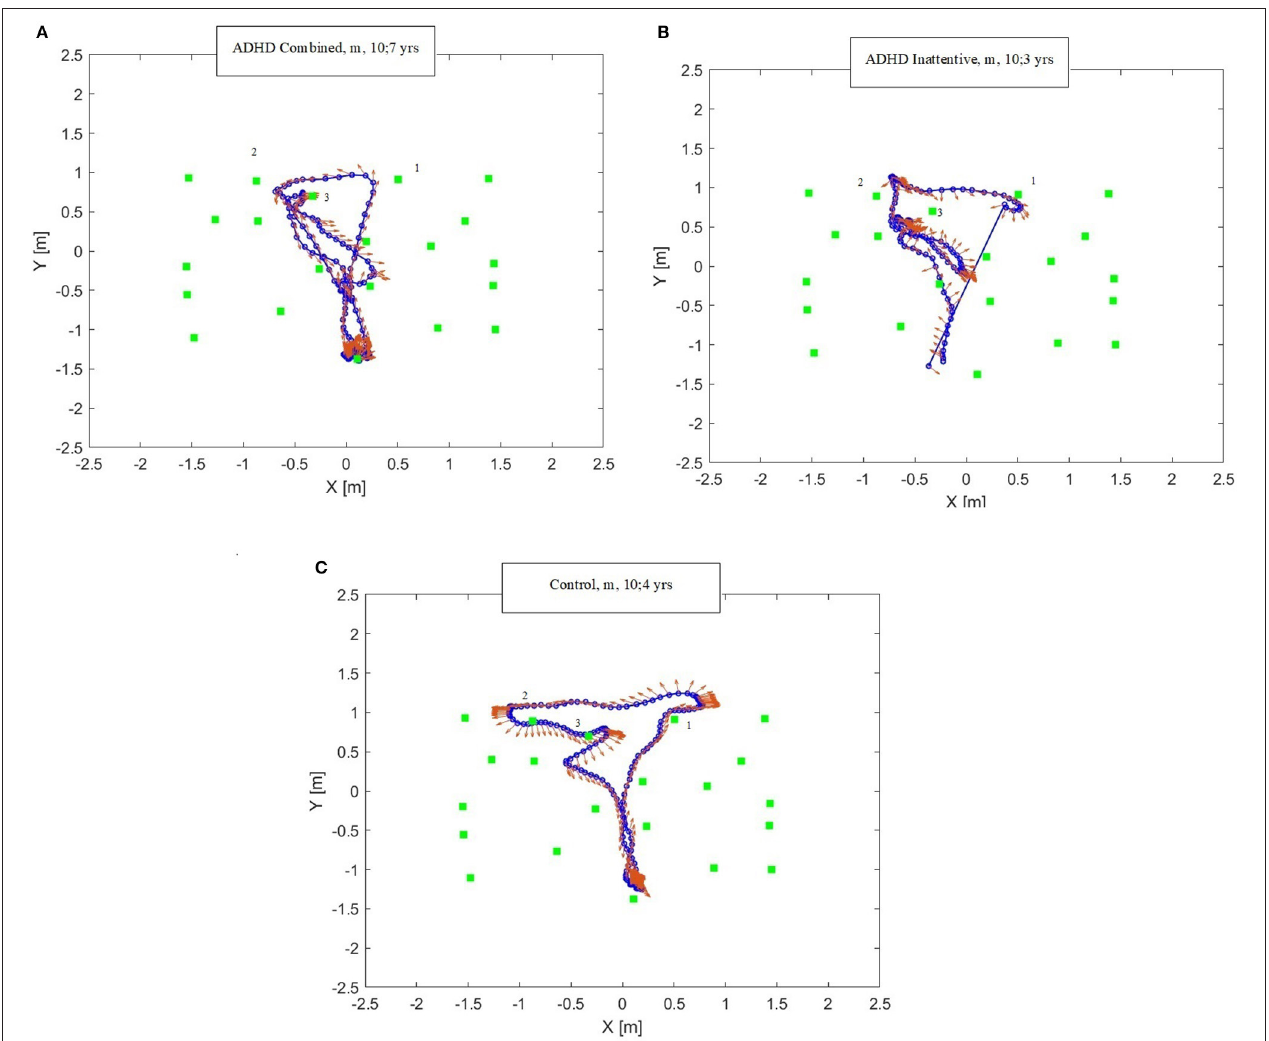
FIGURE 2 | (A–C) Trajectories at the VC TM paradigm of two children with ADHD and one control child. Blue lines and circles: motion trajectories; Red arrows: head direction with respect to the trajectory; Green squares: house position with sequence number on top. X and Y axes indicate the sensors’ position in the navigational array (meters). (A) trajectory of a combined type ADHD child, male, aged 10;7 years; (B) trajectory of an inattentive type ADHD child, male, aged 10;3 years; (C) trajectory of a control subject, male, aged 10;4